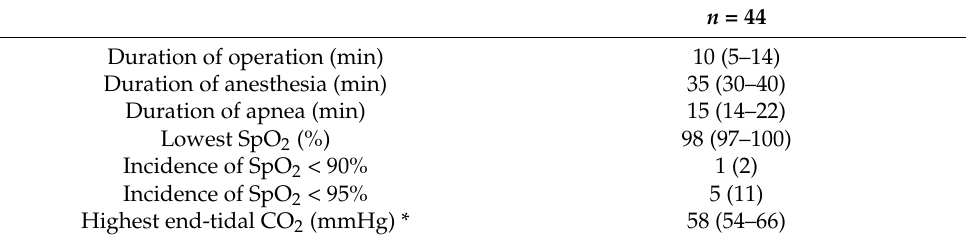
Table 3. Intraoperative Oxygenation